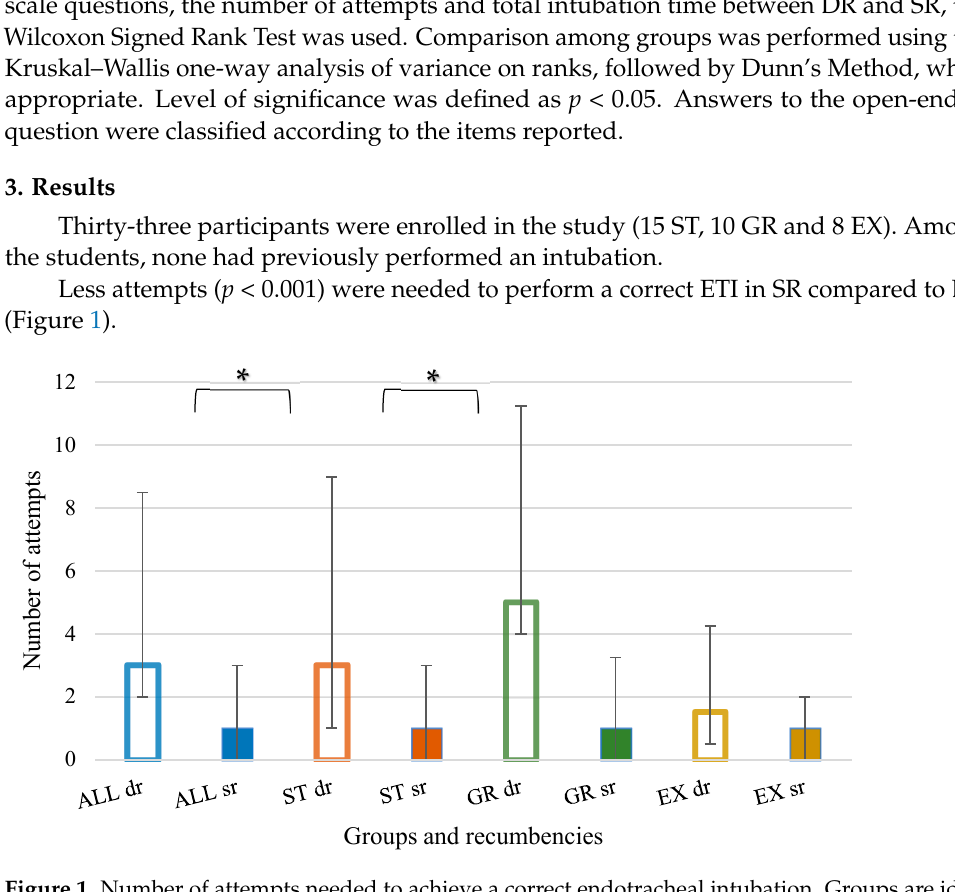
Figure 1. Number of attempts needed to achieve a correct endotracheal intubation. Groups are iden- tified by colours: blue—all; orange—undergraduates (ST); green—graduates (GR); yellow—experts (EX). Recumbencies are identified by bar fill: dorsal recumbency (dr)—no fill; sternal recumbency (sr)—full fill. * Statistically significant difference between recumbencies.